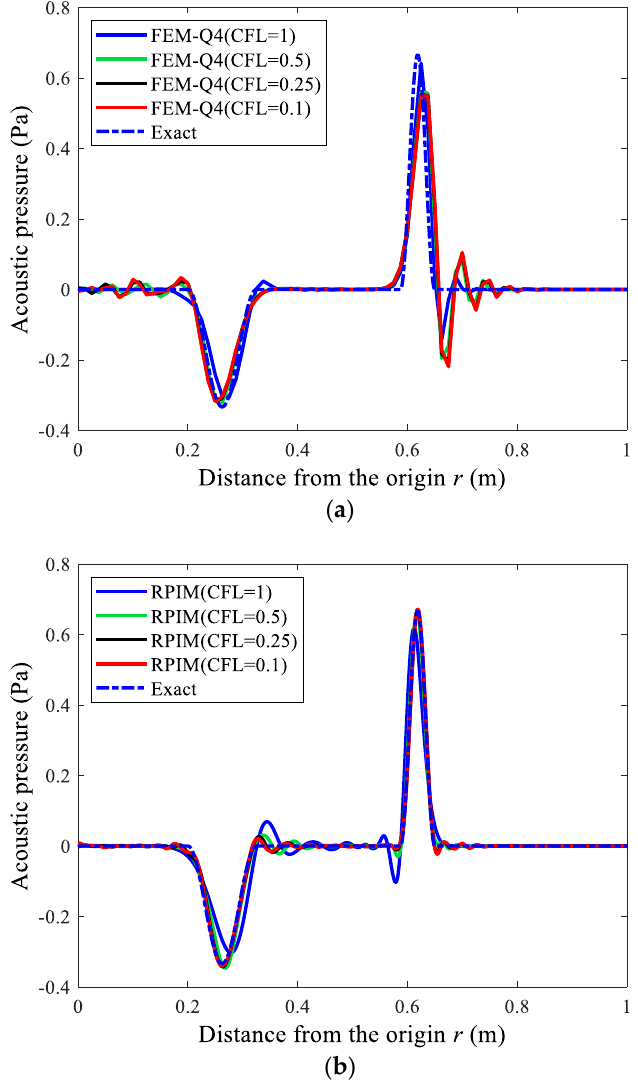
Figure 10. The computed acoustic pressure distribution results from different numerical approaches for the time point t = 0.8 s when the varying non-dimensional time integration steps are employed: ( a ) FEM-Q4; ( b ) RPIM.